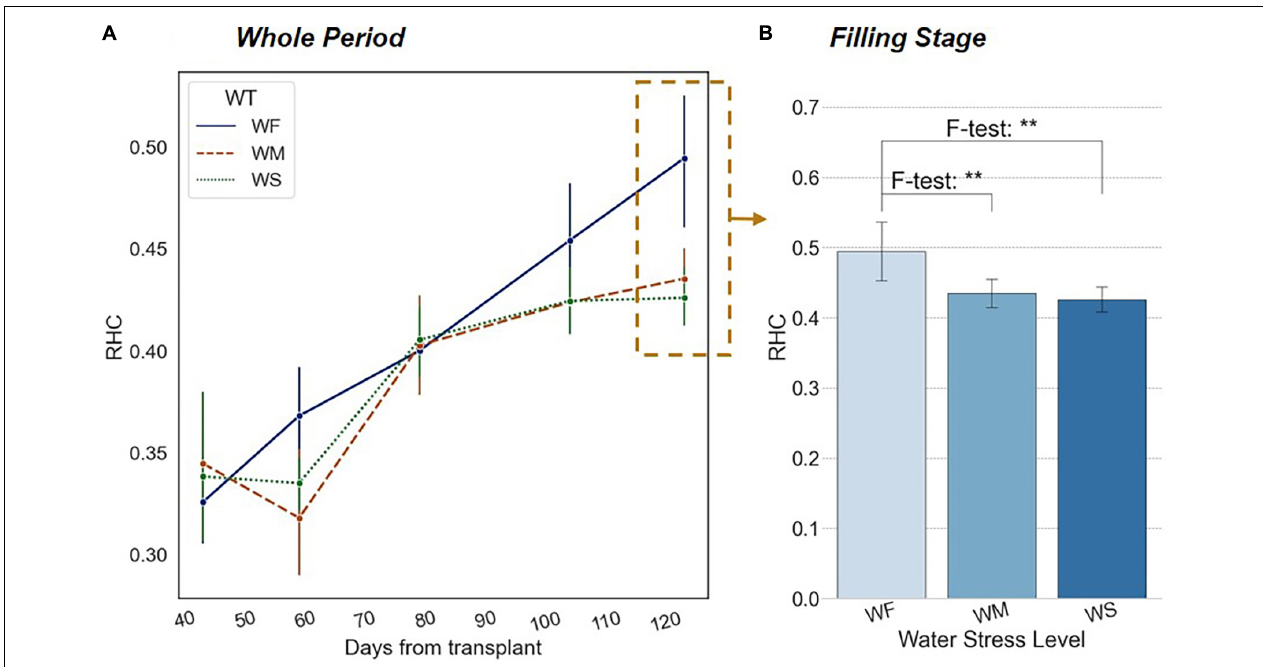
FIGURE 6 | (A) Trends of RHC in different long-term water treatment groups during the whole growth period. (B) Significant differences in RHC among three water treatment groups at the filling stage. The x -axis represents water treatment groups. The blue bars indicate the value of RHC . The number of asterisk (*) represents the degree of the significance ( p -value of < 0.05 *, p -value of < 0.01 **, and p -value of < 0.001